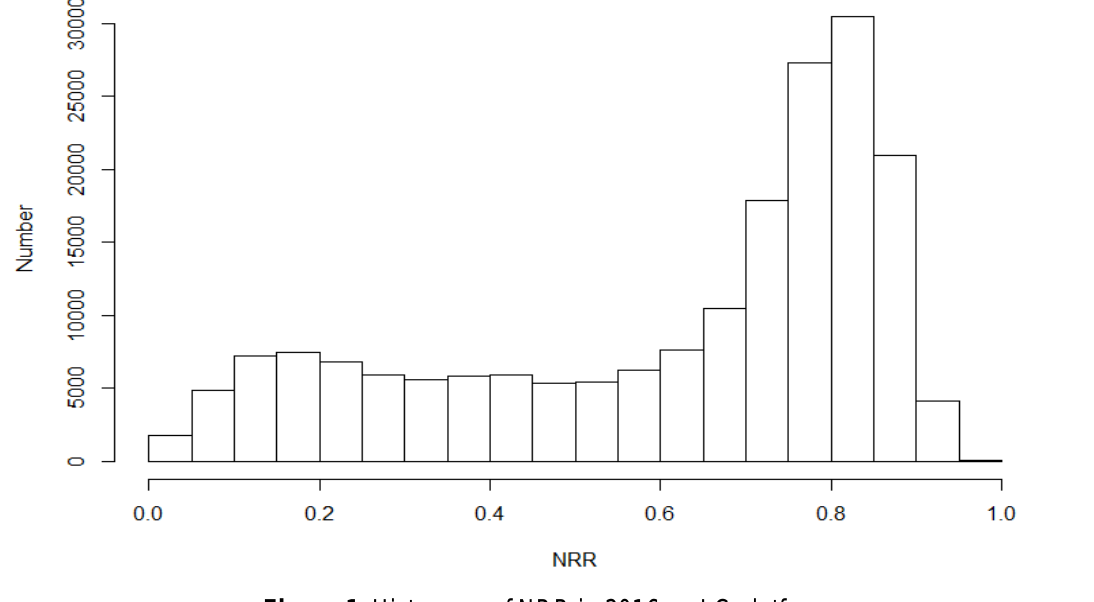
Figure 1. Histogram of NRR in 2016 on LC